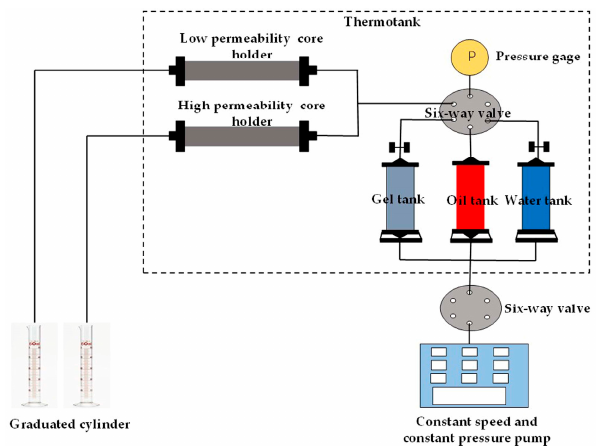
Figure 3. Schematic diagram of the gel flooding experimental device.